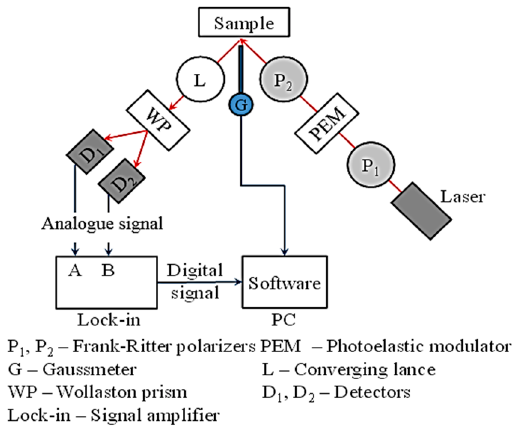
Figure 5. Brief illustration of MOKE.